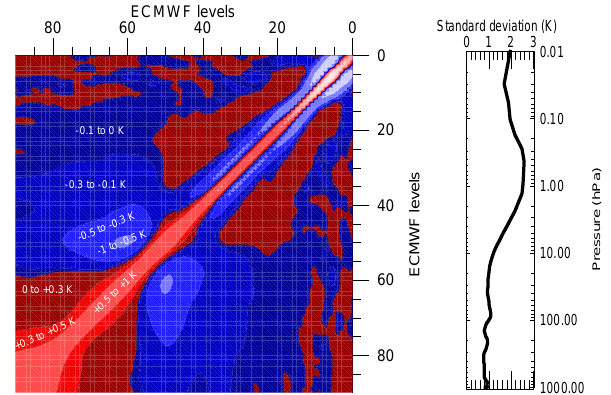
D E · δ vmr δ vmr H Fig. A4. As Fig. A3 but for the terms used H 2 O j 2 O i in Eq. (A14), before conversion from specific humidity to water vapour volume mixing